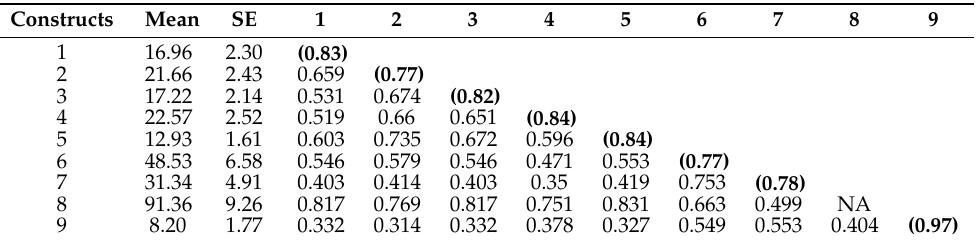
Table 2. Matrix of latent constructs in the measurement